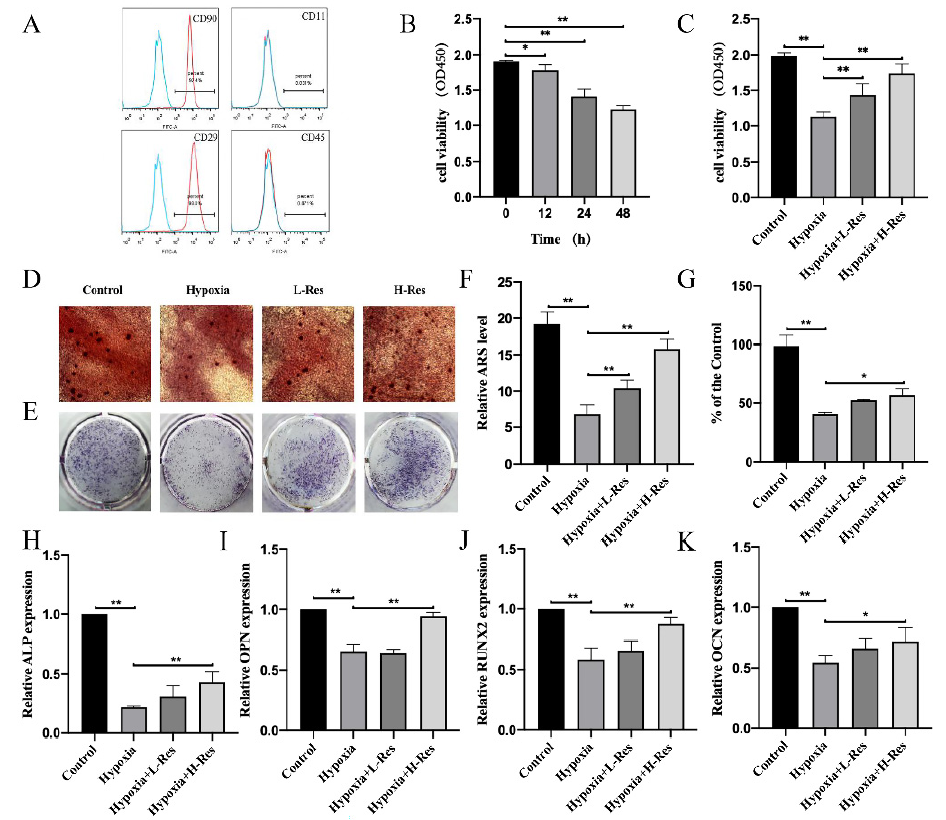
Figure 1. RES promoted the cell viability and osteoblastogenesis in BMSCs under hypoxia . ( A ) Flow cytometry demon- strated that BMSCs presented high expressions of CD29 and CD90, and low expressions of CD11 and CD45. ( B ) The via- bility of BMSCs under hypoxia was measured. ( C ) The viability of BMSCs from control group, hypoxia group, L-RES group and H-RES group was detected. ( D ) ARS staining results of BMSCs from control group, hypoxia group, L-RES group and H-RES group. ( E ) ALP staining results of BMSCs from control group, hypoxia group, L-RES group and H-RES group.( F , G ) quantification for %area. The mRNA expression level of ( H ) ALP, ( I ) OPN, ( J ) RUNX2, ( K ) OCN were meas- ured by RT-PCR. Values were expressed as mean ± SD. * p < 0.05, ** p < 0.01; all the assays were repeated more than three